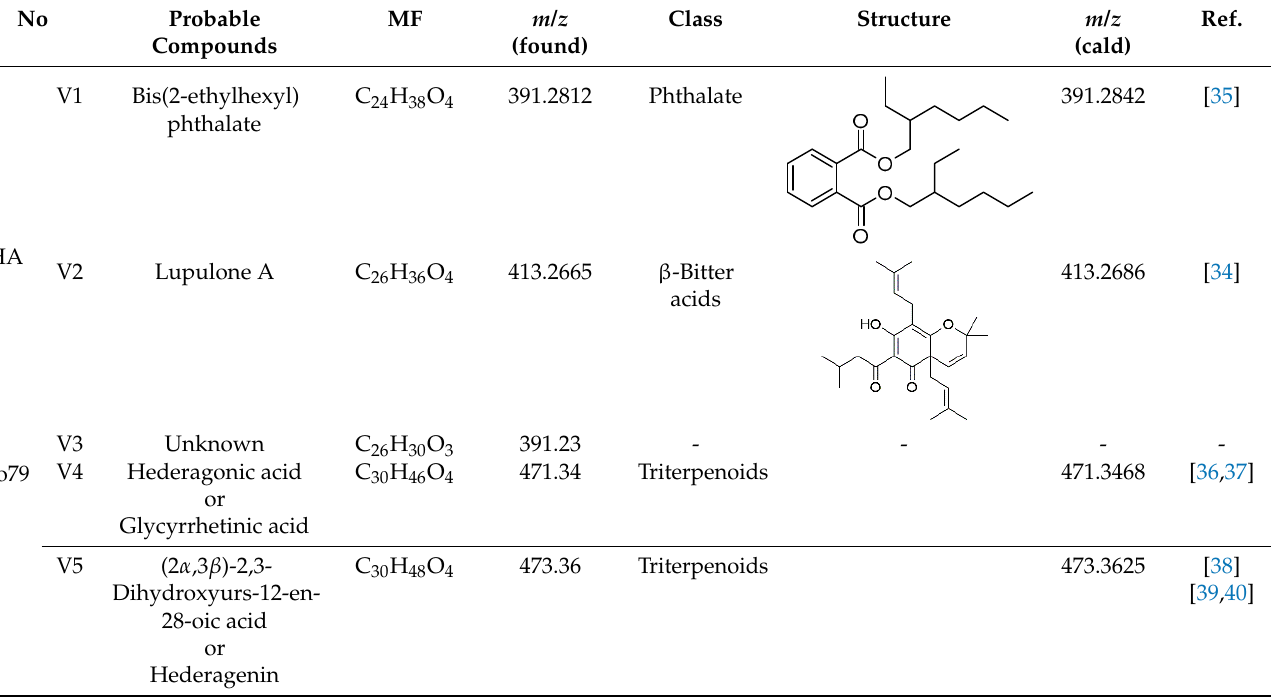
Table 2. Tentative identification of the phytochemicals of V. officinalis extracts.